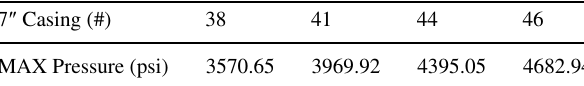
Fig. 8 Variation of additional buckling force compared to casing depth (7 ″ (32#) casing) Table 3 Maximum allowable surface pressure for 7 ″ cement job